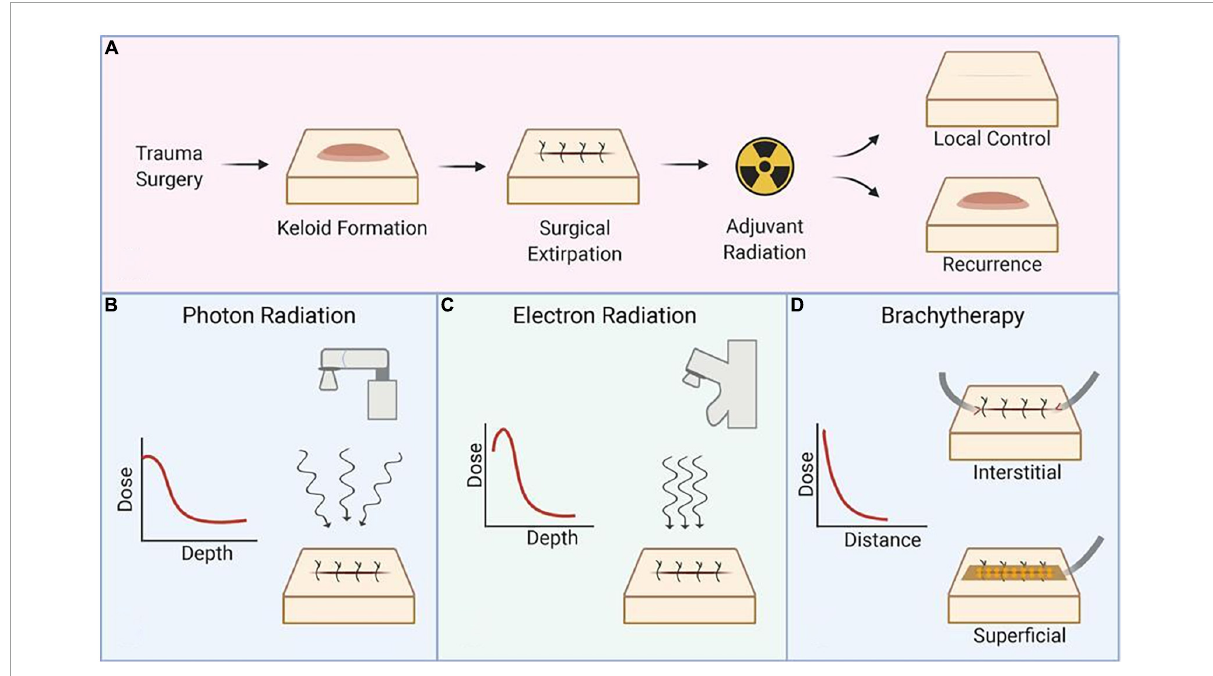
FIGURE1 Schematic representation of the radiation technique. (A) Process and prognosis of postoperative radiotherapy for keloids, (B) mechanism of X-ray and selection of dose and depth, (C) mechanism of electron radiation and selection of dose and depth, and (D) mechanism of brachytherapy and selection of dose and depth. Reproduced with permission from Journal of Plastic, Reconstructive & Aesthetic Surgery (19).